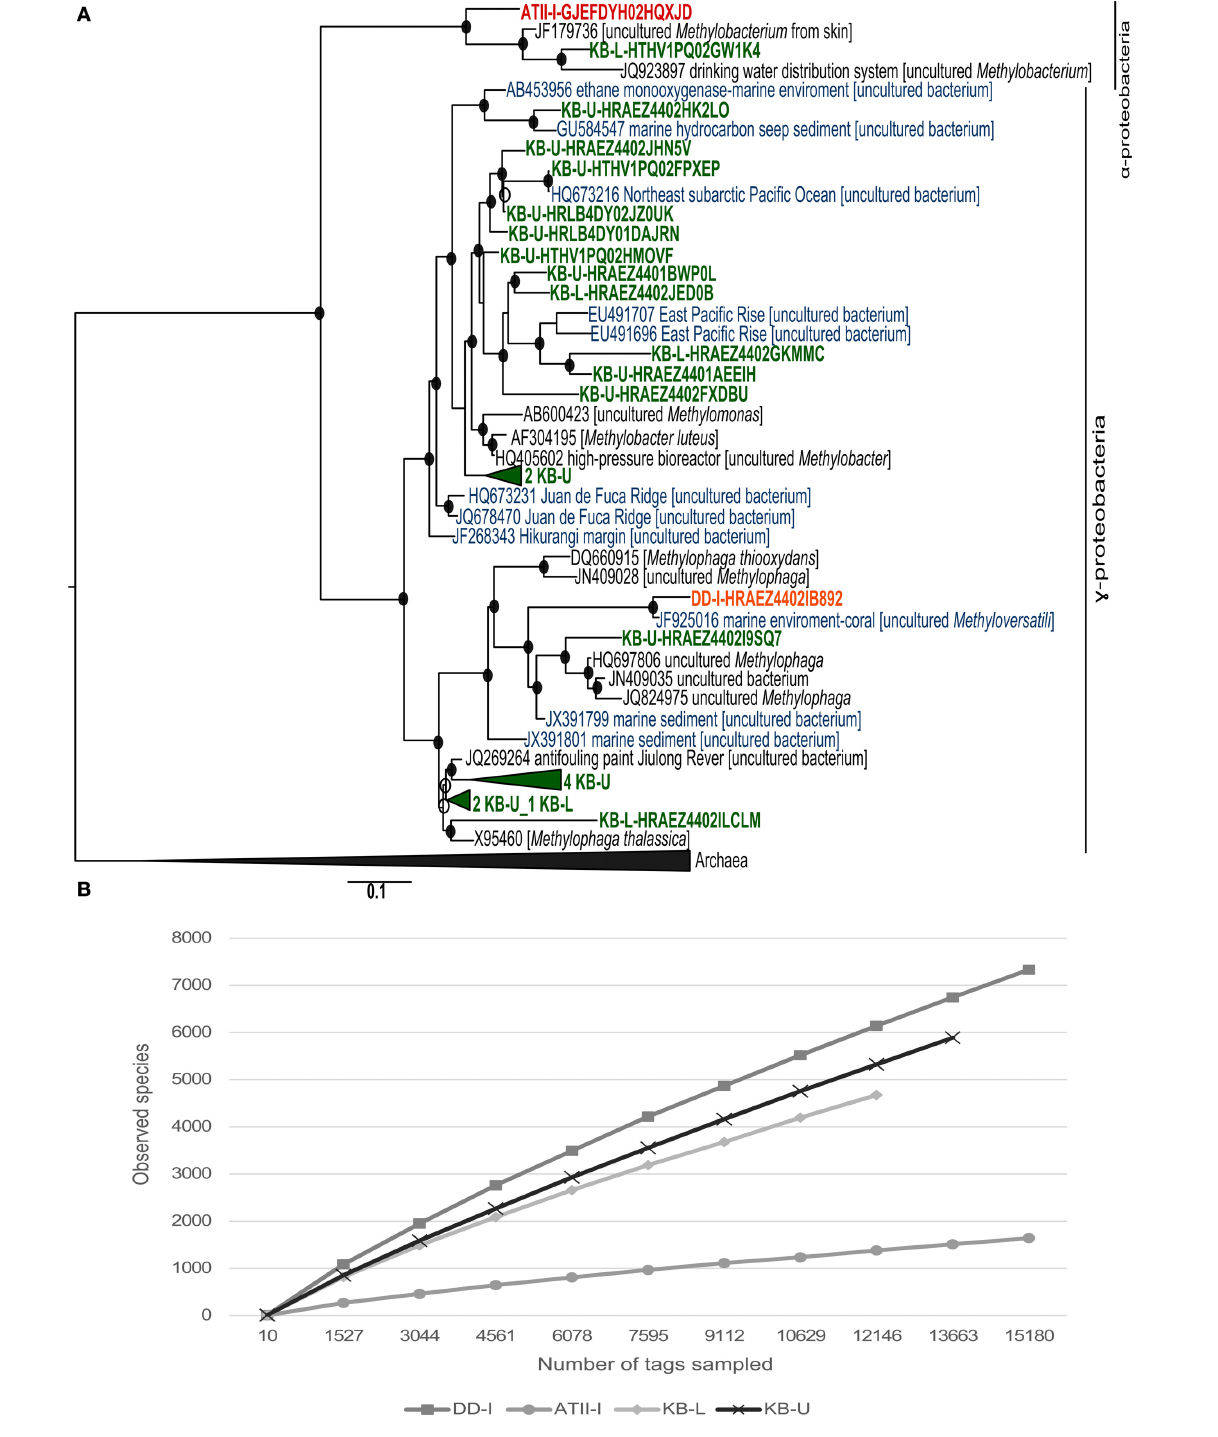
FIGURE 3 | 16S rRNA phylogenetic tree and species richness of aerobic methanotrophs. (A) Nucleotide phylogeny of the predicted 16S rRNA pyrotags generated from ATII-I (red), DD-I (orange) and KB-U/KB-L (green). Blue sequences represent 16S rRNA derived from marine environments. Red Sea brine pool OTUs based on 99% sequence identity were compared with SILVA 16S rRNA. The tree was generated using an 1891-bp alignment. The numbers of sequences collapsed in the selected node are indicated adjacent